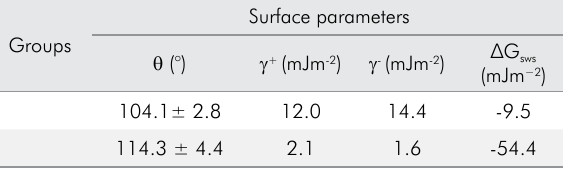
Table 1. Water contact angle ( θ ), surface tension parameters ( γ +, γ -), and degree of hydrophobicity (∆Gsws) of acrylic resin blocks in the control group (CG) and of those treated with silicon dioxide (LG group). The values are represented by the means ± standard deviations of three independent experiments for each condition.